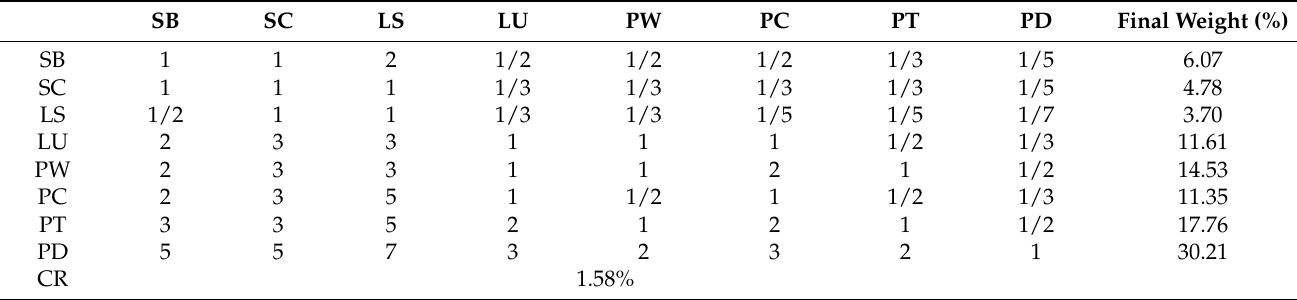
Table 2. Result of Decision Matrix and Final Weights of